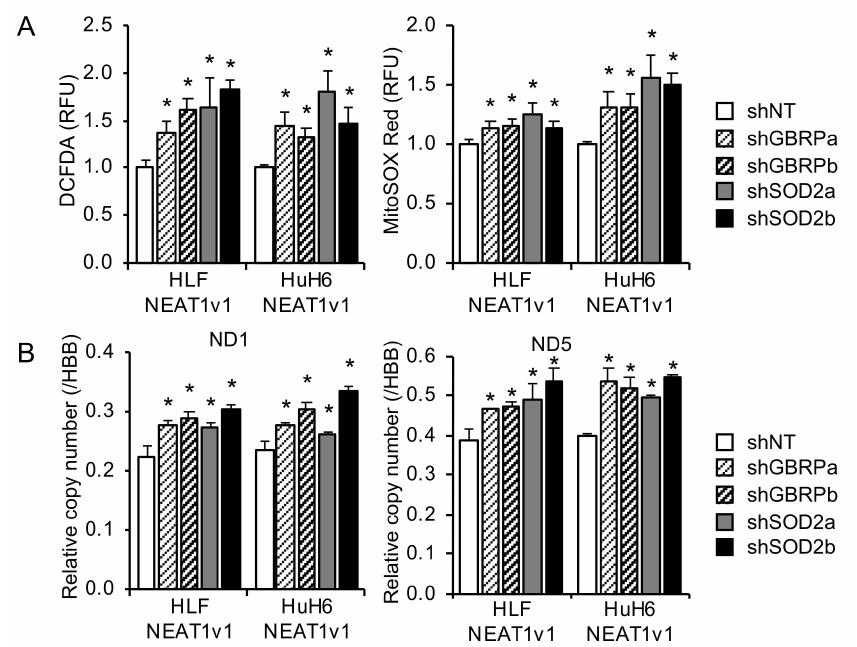
Figure 4. Involvement of GABARAP and SOD2 in the suppressive effects of NEAT1v1 on radiation- induced mitochondrial damage. ( A , B ) Cellular (left) and mitochondrial (right) oxidative stress ( A ) and relative copy number of mitochondrially encoded genes (ND1 and ND5); ( B ) in NEAT1v1- overexpressing HLF and HuH6 cells knocked down for GABARAP (shGBRPa and shGBRPb) or SOD2 (shSOD2a and shSOD2b) after 5 Gy irradiation. * p < 0.05 [Dunnett’s test vs. shNT; n = 6 ( A ) and 3 ( B